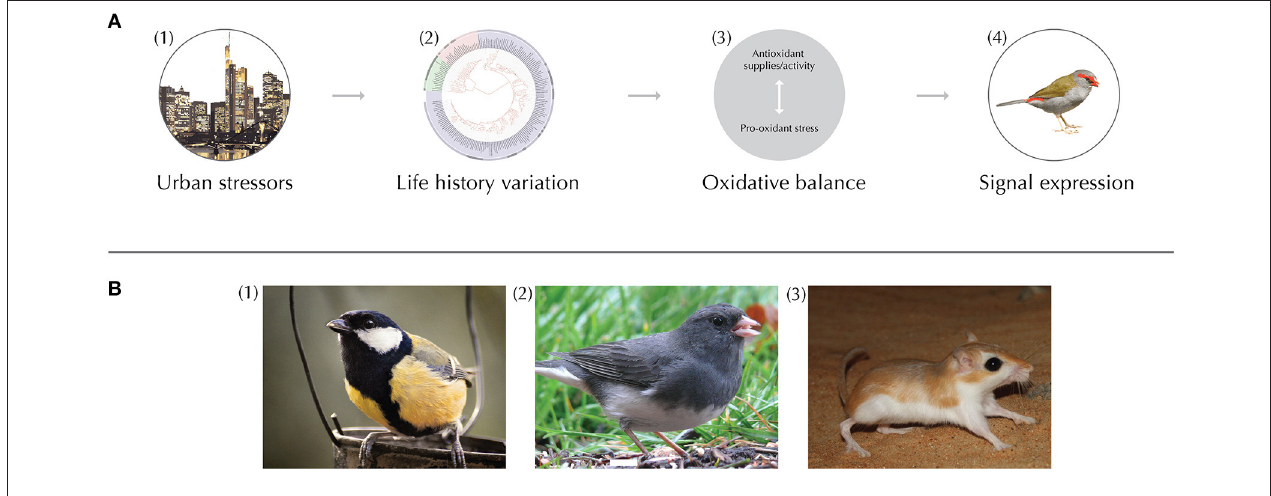
FIGURE 1 | (A) Conceptual diagram depicting urban effects on oxidative balance (OB) and signal expression. (1) Urban environments can produce unique stressors for animals, such as chemical, noise and light pollution, and habitat and diet alteration. (2) Animals respond to urban stressors based on their unique life-histories, which include the physiological and behavioral sensitivity to stressors during particular phases of life (e.g., development, dispersal, breeding). Additionally, within life-history stages, current physiological condition and behavioral/physiological plasticity likely mediate susceptibility to changes in OB. (3) Ultimately, these